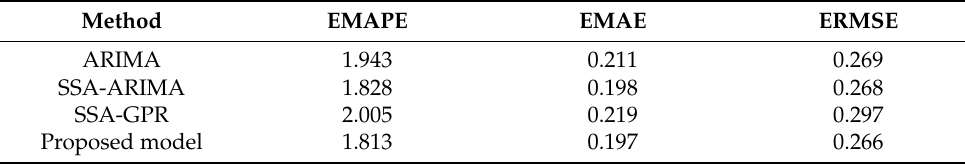
Table 1. Comparison of deterministic prediction model